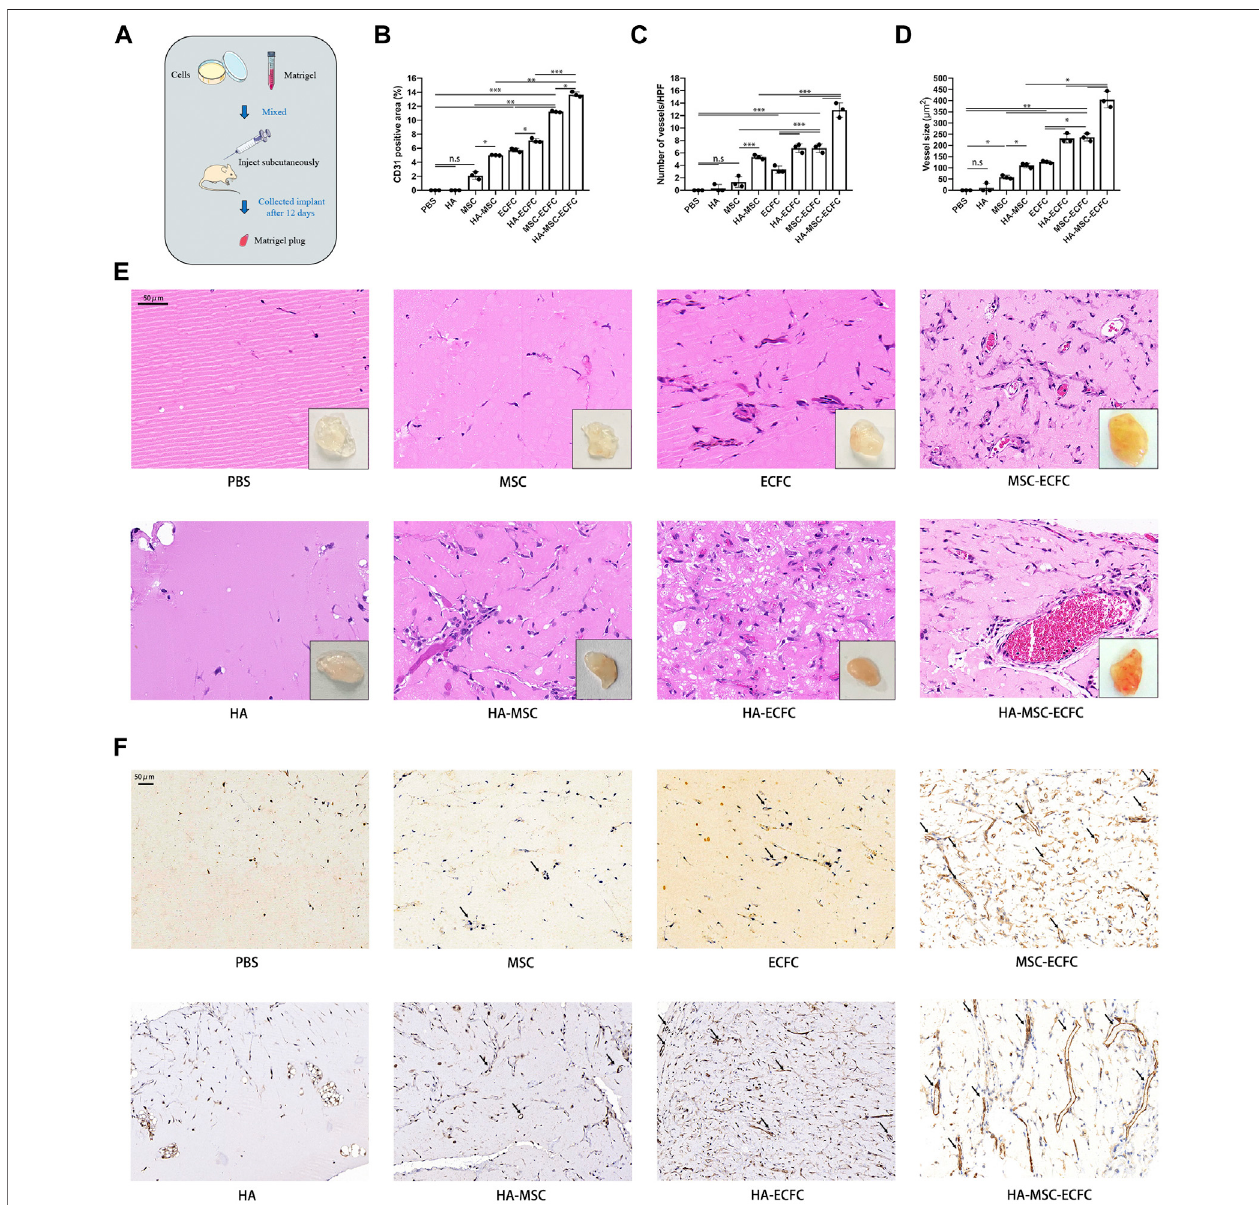
FIGURE 2 | HA promotes MSC-ECFC-induced angiogenesis of Matrigel plugs in vivo . (A) . The procedure for Matrigel plug in vivo assays. (B – D) . Quantitation of vesselnumberfromtheH&E-stainedparaf fi nsectionsandquantitationofthehuman-speci fi cCD31-positivepercentageandvesselsize. (E,F) Representativeimagesof macroscopeviewofexplantedMatrigelplugs,H&Estaining(magni fi cation×400)andimmunobiologicalhumanCD31staining(magni fi cation×200)ofexplantedMatrigel plugs. ( n = 3 independent experiments. Scale bar represents 50 μ m. Error bars: mean ± SD. * p < 0.05, ** p < 0.01, *** p < 0.001).